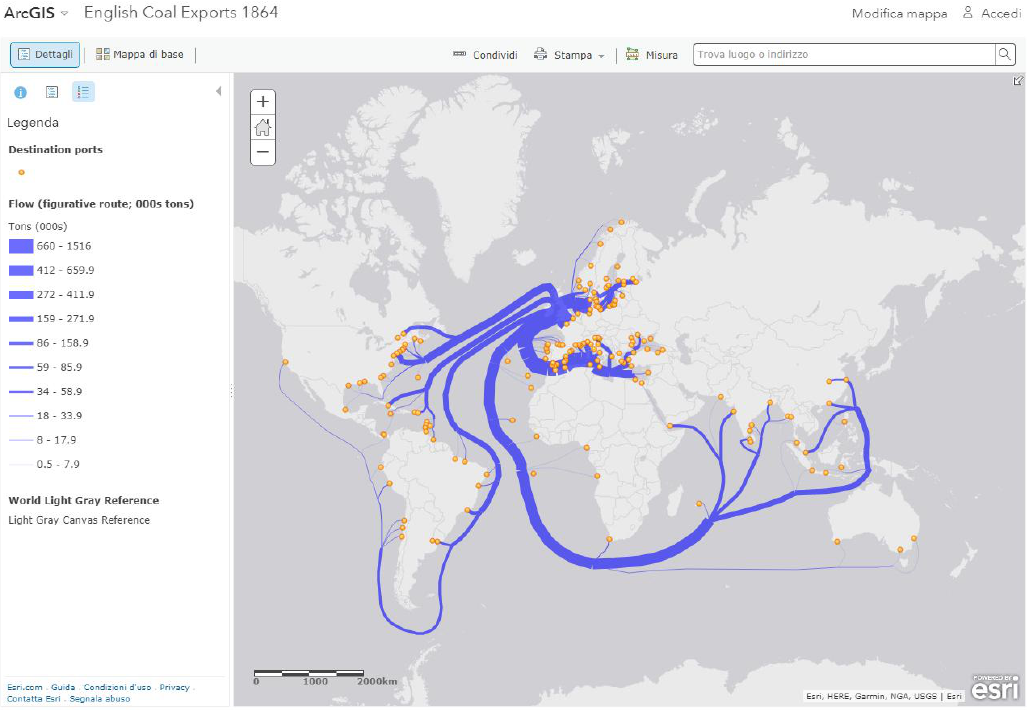
Figure 4. A webGIS of Minard’s flow maps (www.arcgis.com/home/webmap/viewer.html?webmap